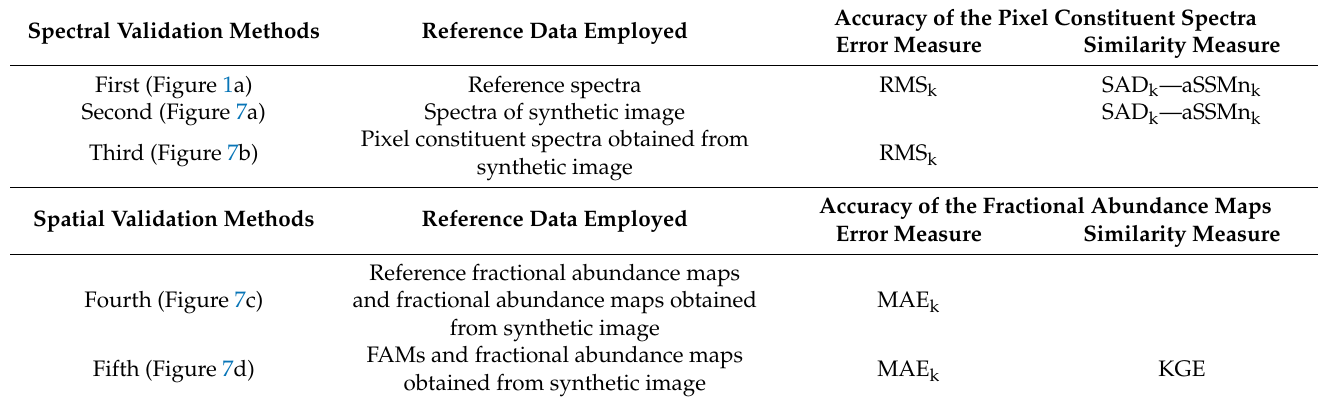
Table 3. The metrics performed to evaluate the spatial and spectral accuracy in the five